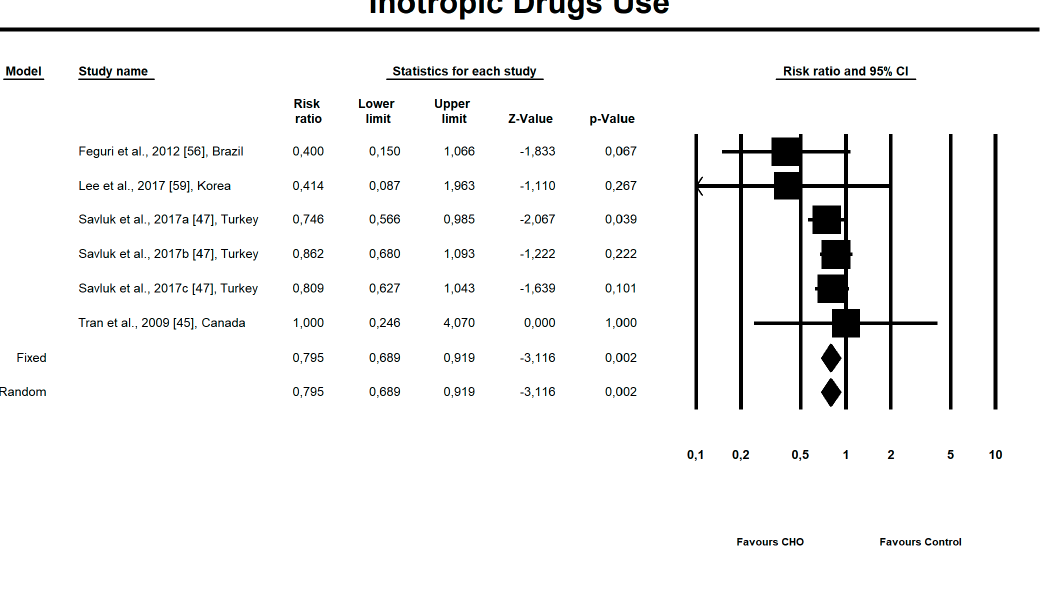
Figure 7. An effect size, difference in means, for exogenous insulin units (IU) in intensive care unit (ICU) postoperatively in patients taking oral carbohydrates (OCH) drinks vs. controls. 95%Cl – 95% confidence interval.